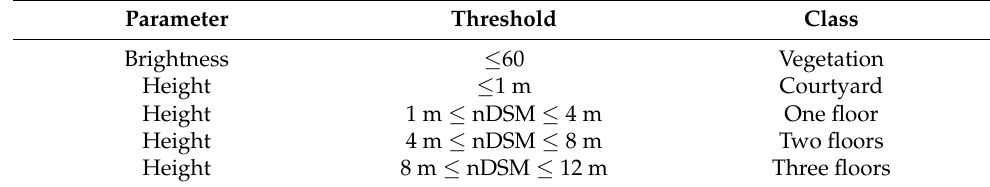
Table 4. Classification rules for the vegetation and the number of building floors.